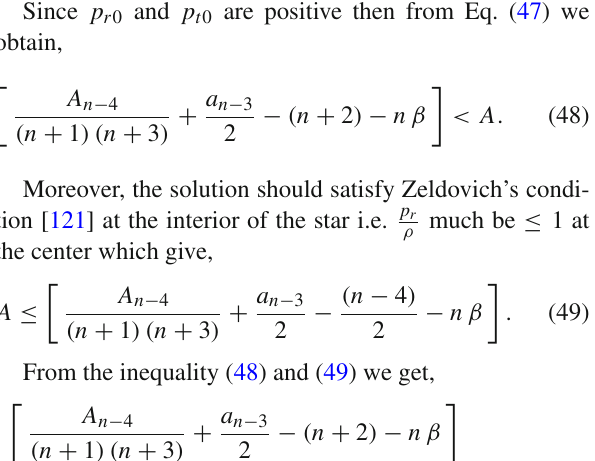
Fig. 2 Behaviour of gravitational potentials e ν( r ) and e λ( r ) vs. radial coordinate r / R with different values of n for LMC X − 4